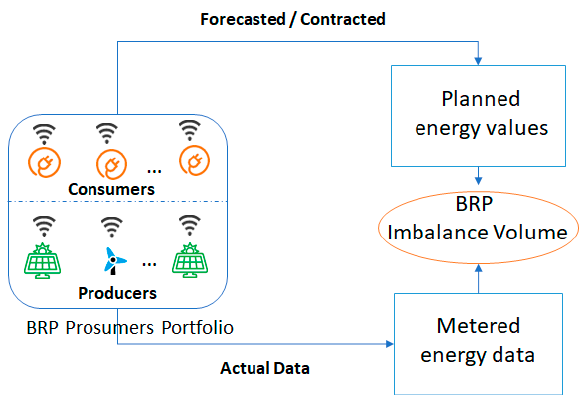
Figure 6. Imbalances settlement process use-case.